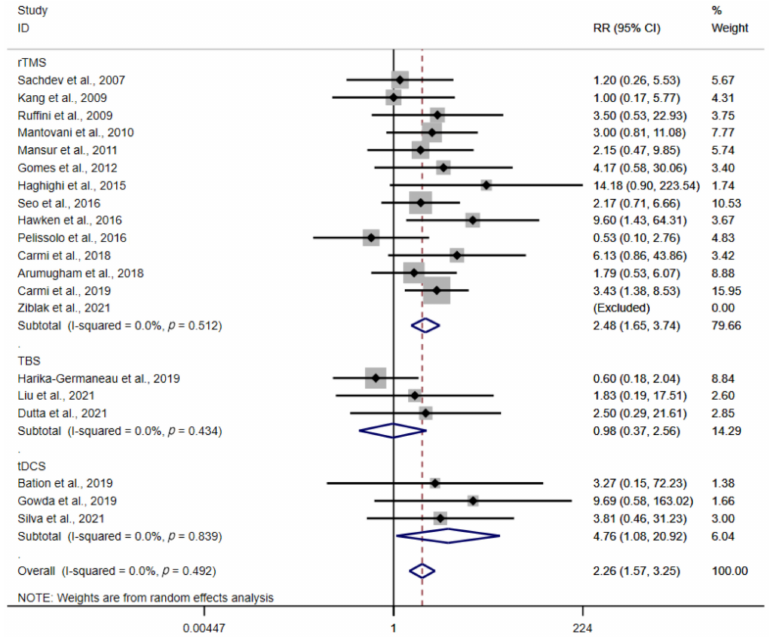
Figure 6. Forest plot of response rates